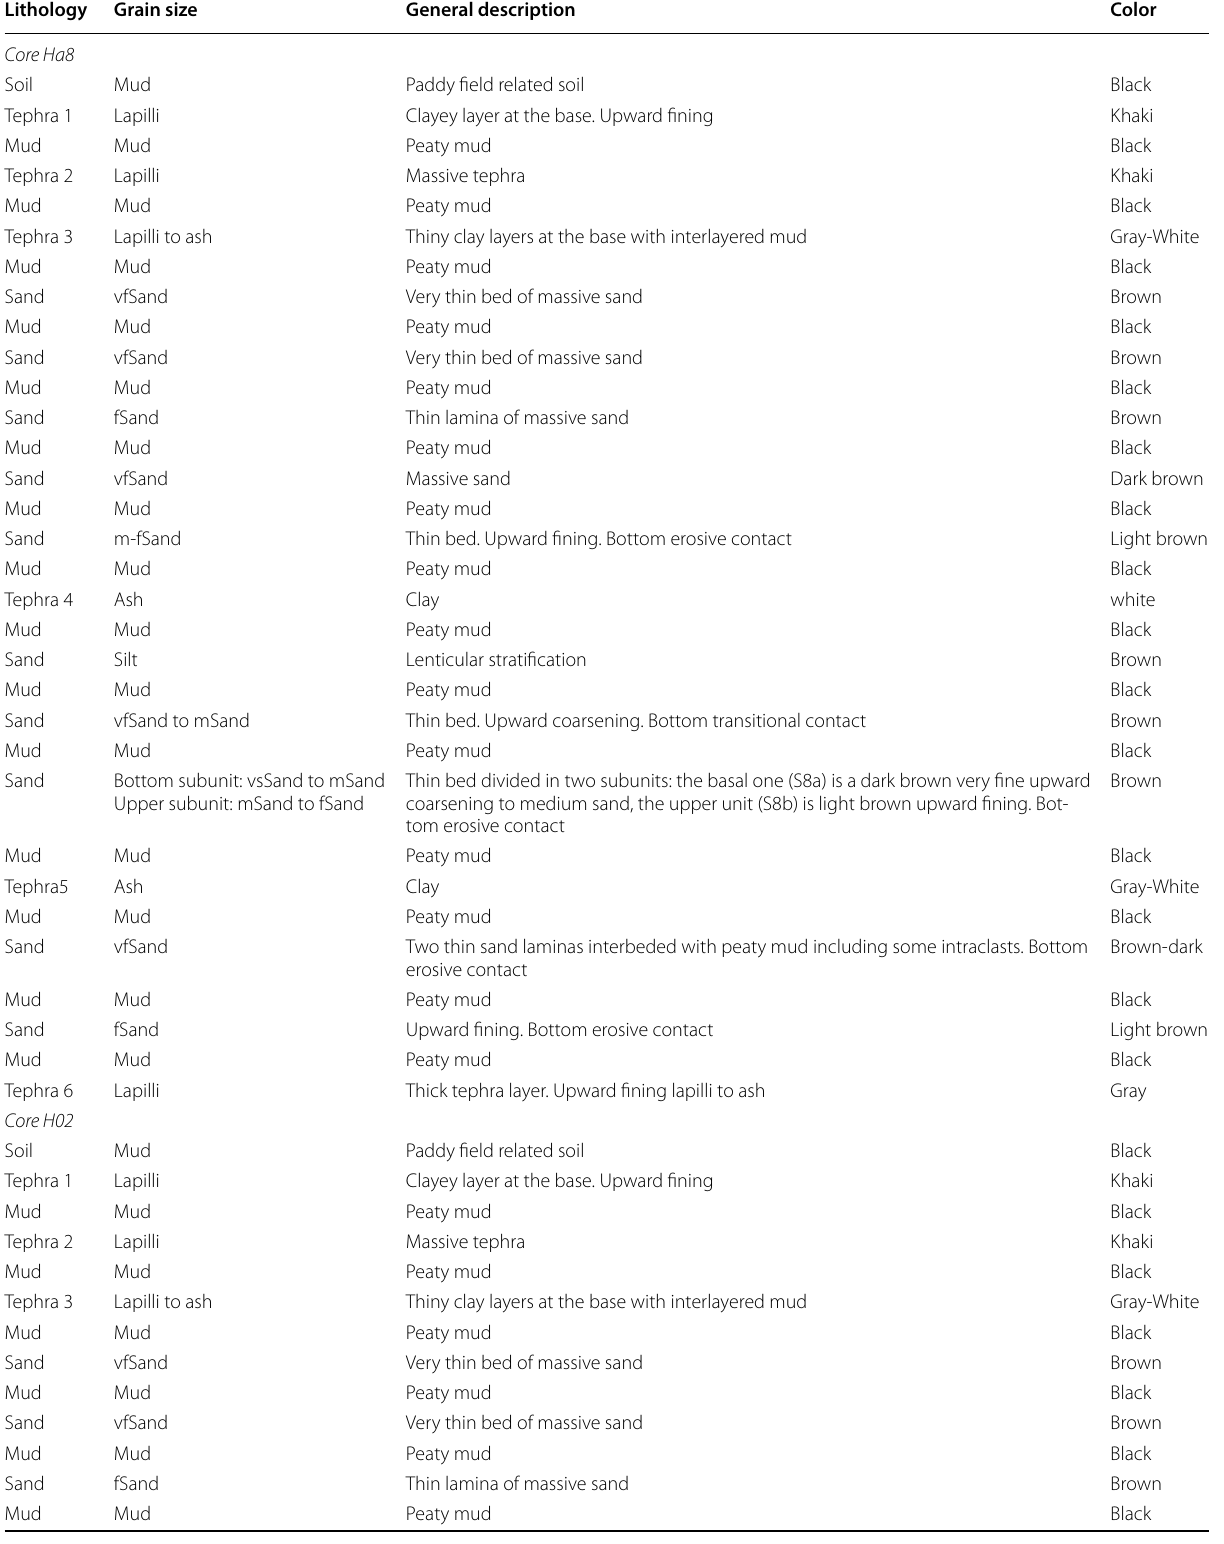
Table 1 General sedimentological characteristics of the sand layers found in the five main cores